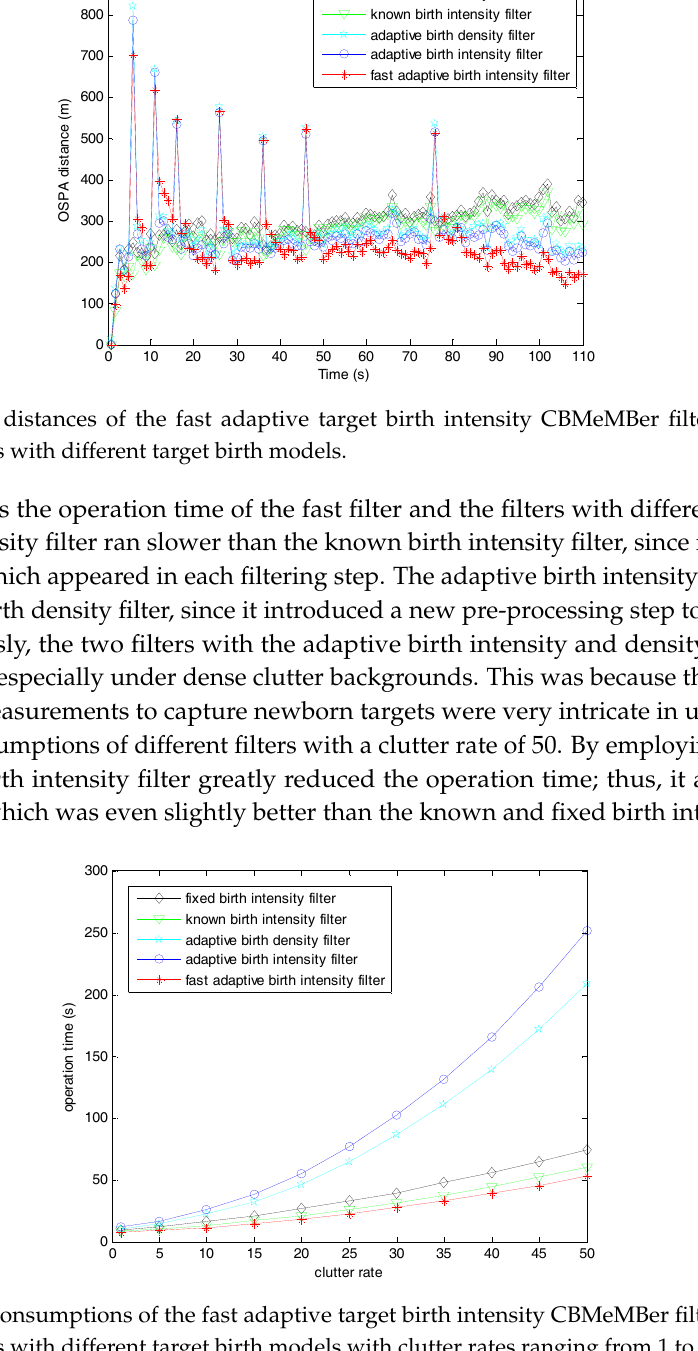
Figure 10. Time consumptions of the fast adaptive target birth intensity CBMeMBer filter and other CBMeMBer filters with different target birth models with clutter rates ranging from 1 to 50.